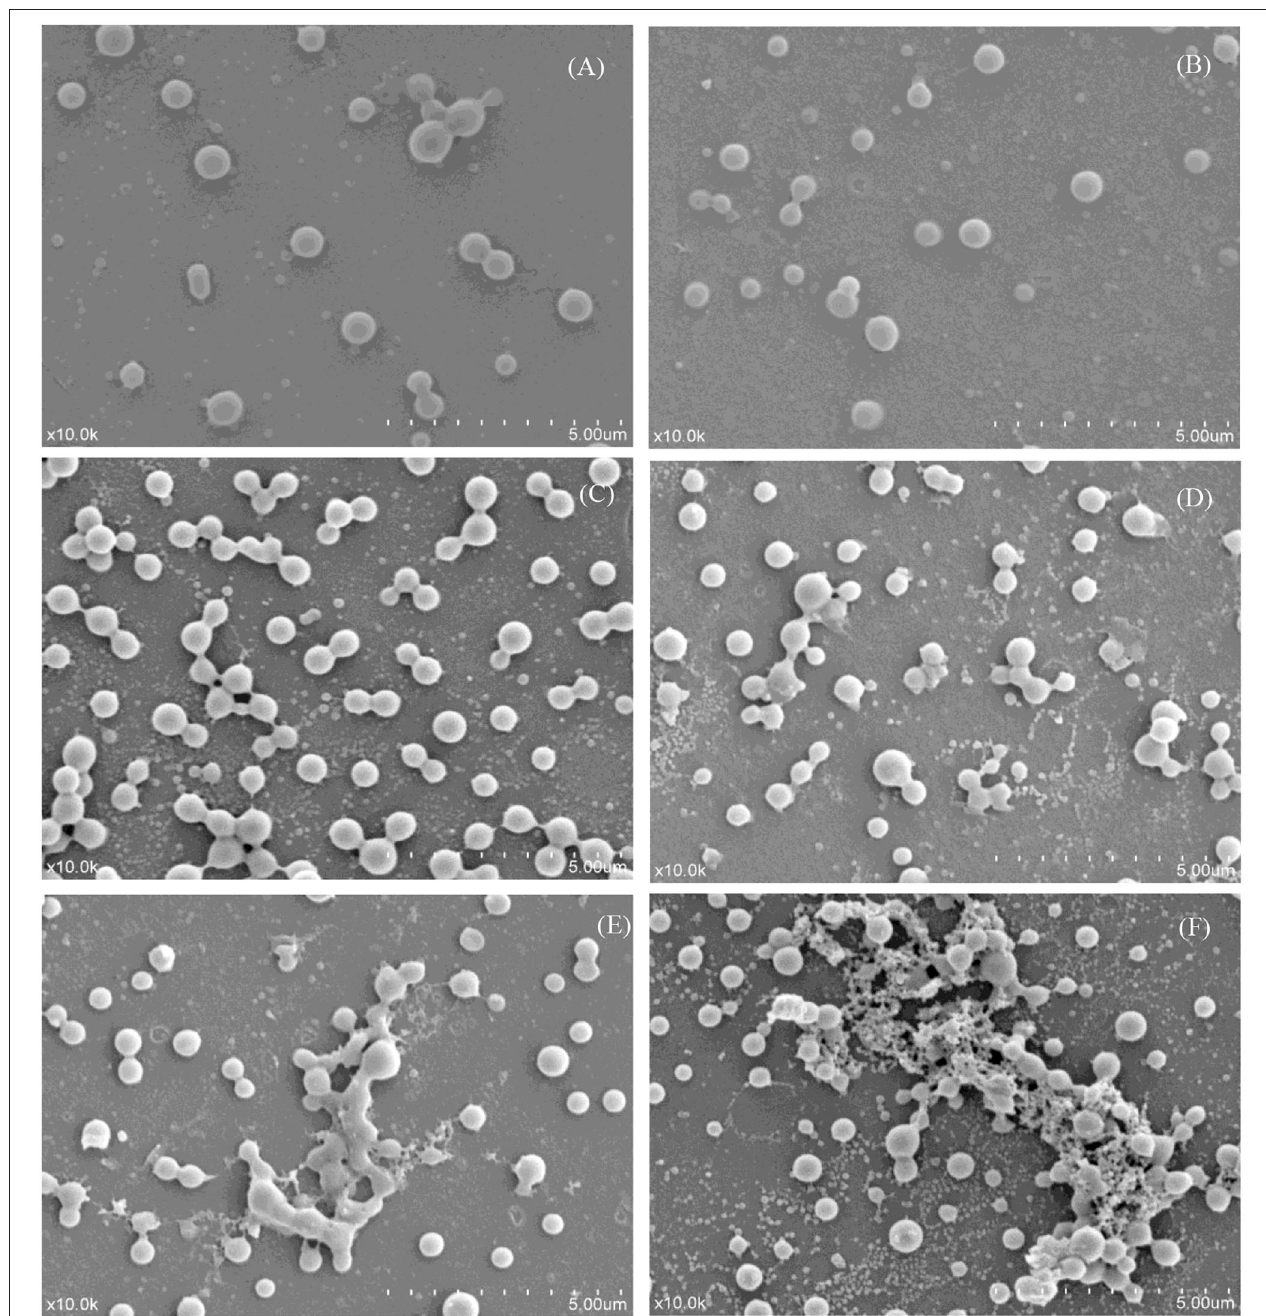
FIGURE 4 | Scanning electron micrographs of different heat-treated skim milk. (A) Skim milk without heat treatment; (B–F) skim milk heat treated at 55, 65, 75, 85, and 95 ◦ C, respectively. All the micrographs were originally taken at a magnification of 10,000 × . The scale bar represents 5 µ m.